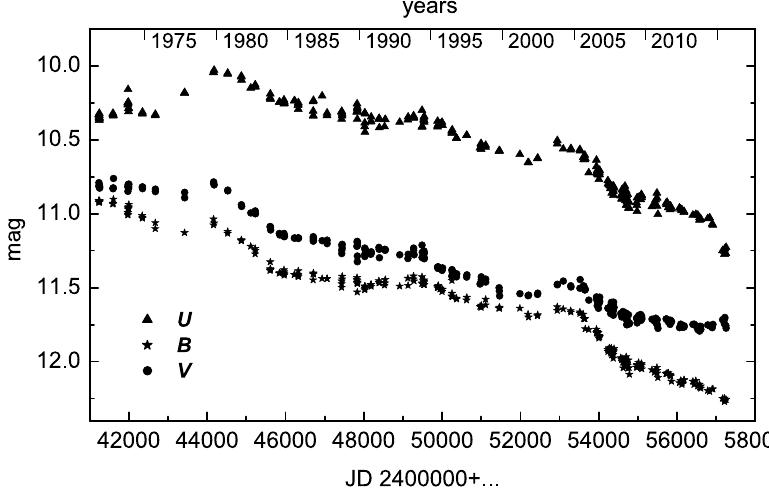
Fig. 1. UBV light curves for V1016 Cyg in